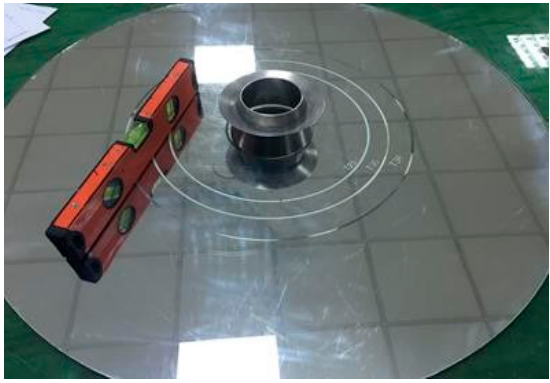
Figure 5. Hagerman mini slump cone apparatus